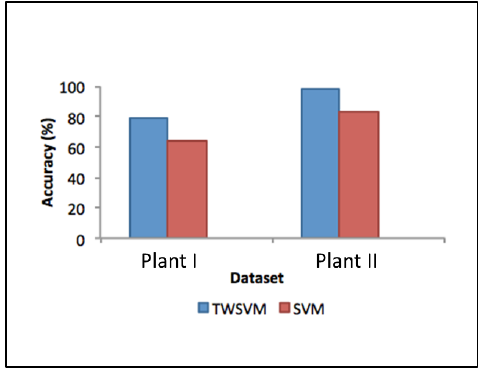
Figure 7. A comparison between accuracy results of SVM vs. TWSVM-based models.